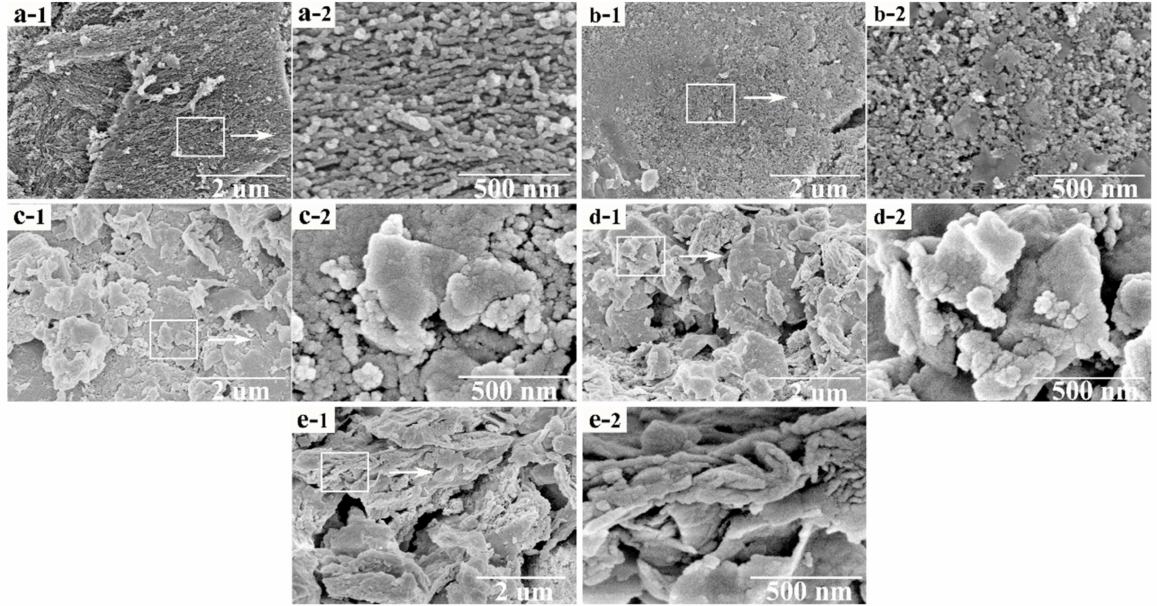
Figure 5. SEM surface topography of ( a ) AC, ( b ) fresh catalyst, ( c ) sulfur poisoning, ( d ) thermal regeneration, and ( e ) rinsing regeneration. Figure (a-1, b-1, c-1, d-1, e-1) shows the surface morphology of activated coke at 20,000 times magnification. Figure (a-2, b-2, c-2, d-2, e-2) shows the surface morphology of activated coke at 100,000 times